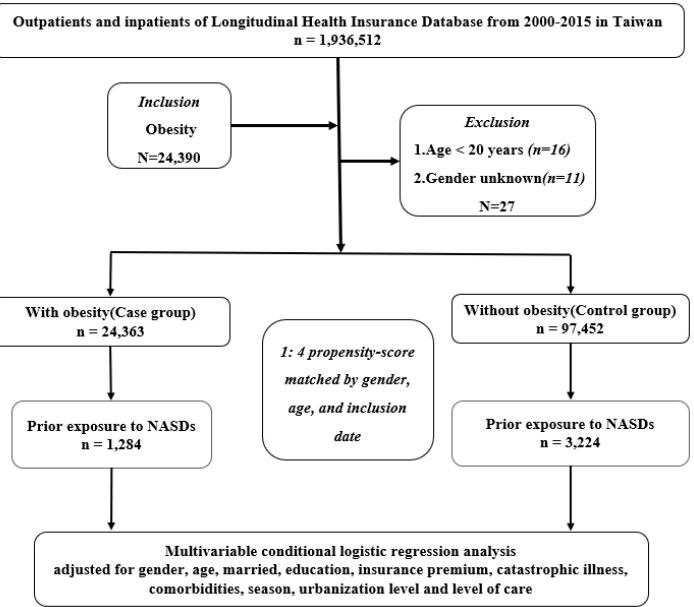
Figure 1. Flowchart the study design from the National Health Insurance Research Database in Tai- wan.